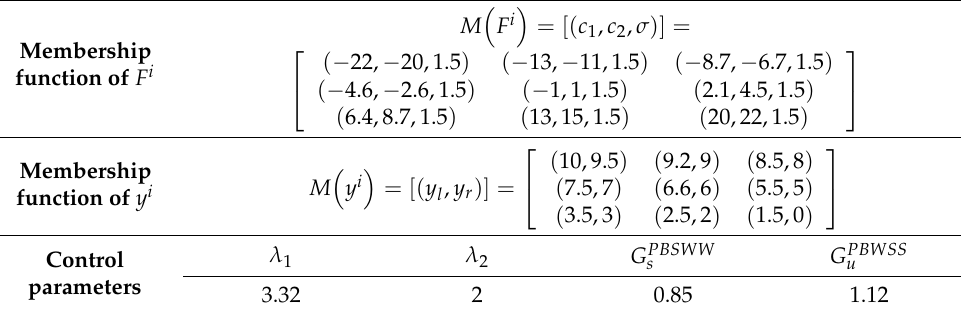
Table 4. The used parameters of the PBWSS with the IT2FSC for the static unloading force control.